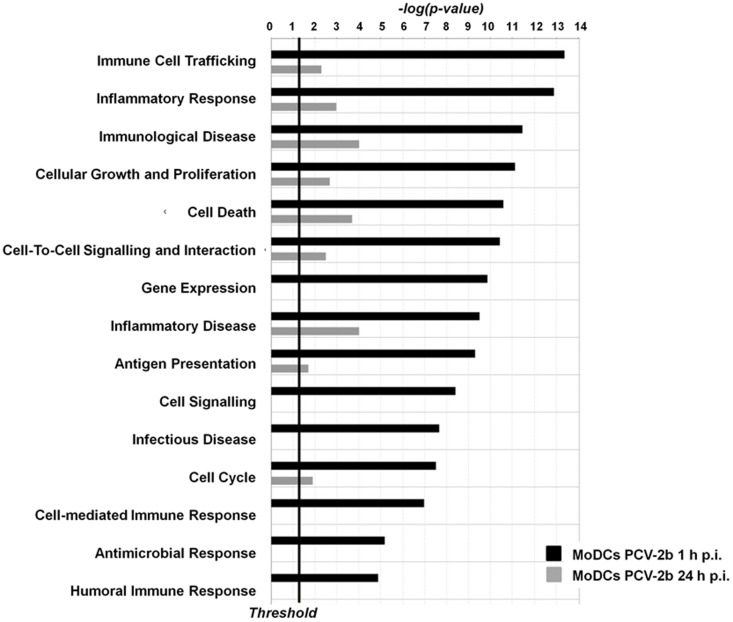
Biological process analysis of genes differentially expressed in MoDCs at 1 h and 24 h post PCV2b challenge.Differentially expressed genes (P<0.05) were imported into IPA Ingenuity software to determine significantly enriched biological processes. Data represent the distribution in cell function categories of statistically significantly enriched biological processes (P<0.05) at 0 h and 24 h post PCV2b challenge.